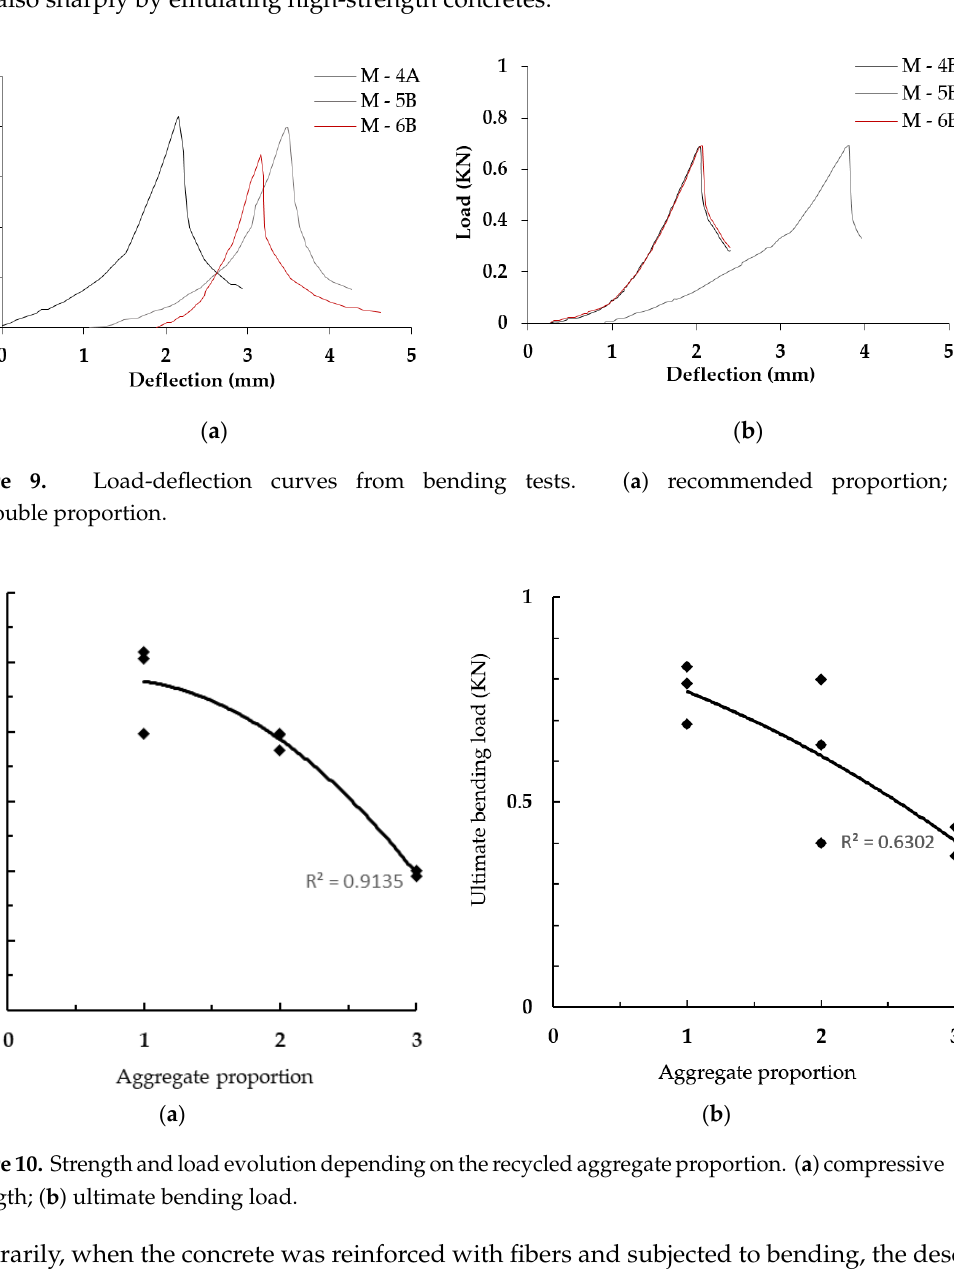
Figure 9. Load-deflection curves from bending tests. ( a ) recommended proportion; ( b ) double proportion.